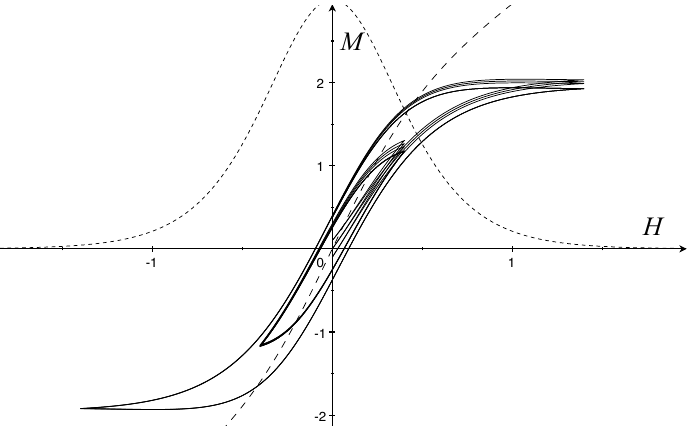
Figure 4. Soft iron hysteresis loops with the saturation properties (solid): µ 0 , τ h = 1, α = 2/3, and f ( H ) = 1.5 ( tanh2 H + H ) (dashed) and g ( H ) = 3/ ( cosh2 H ) 2 (short